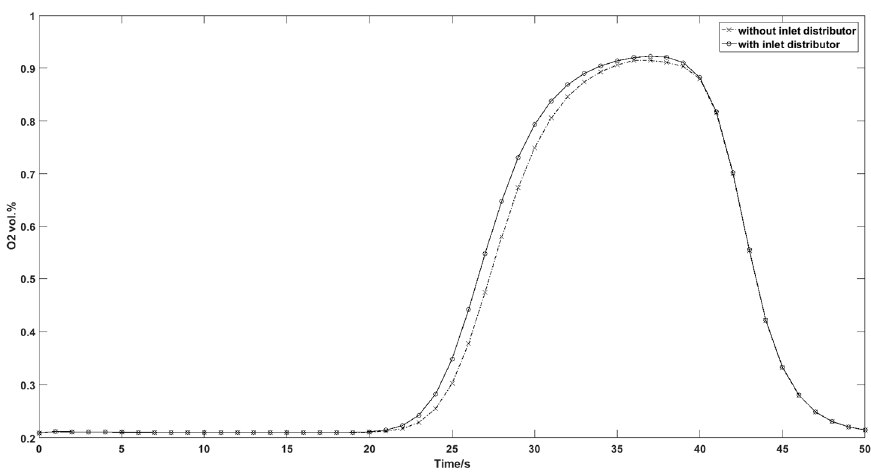
Figure 17. Simulation results of outflow oxygen concentration for different inflow type.